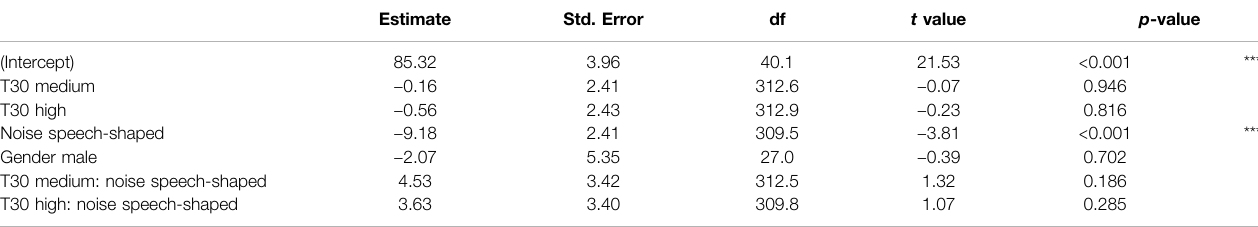
TABLE 8| LME models fi t byREML for theresponsevariable self-reported vocal controland the fi xed factors 1)T30, 2) noise, 3) gender, and 4) the interaction between T30 and noise. Estimate Std.